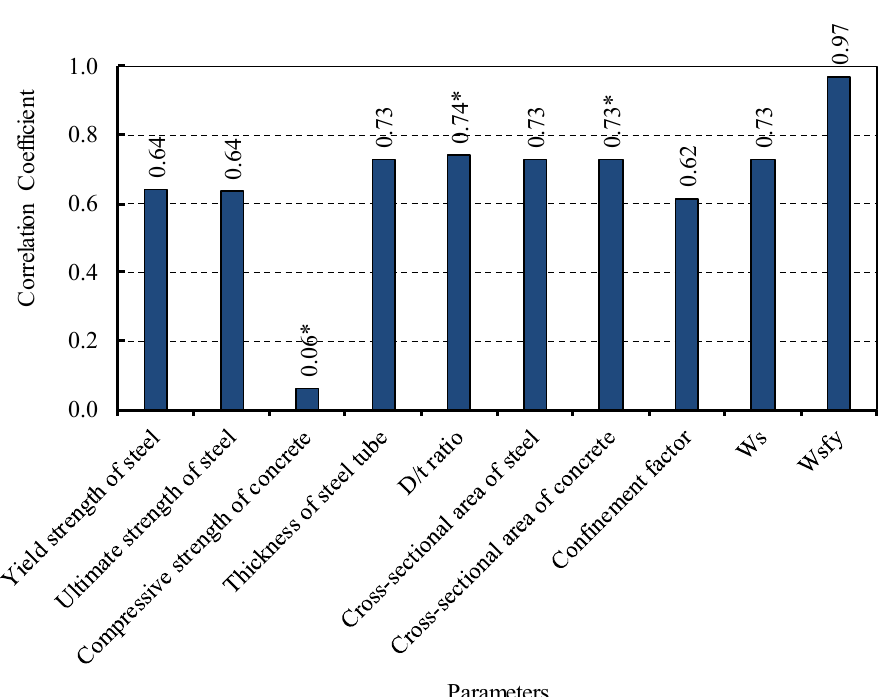
Figure 14. Correlation between the nominal yield moment M y and parameters. Table 3. Correlation between the nominal yield moment M y and parameters.